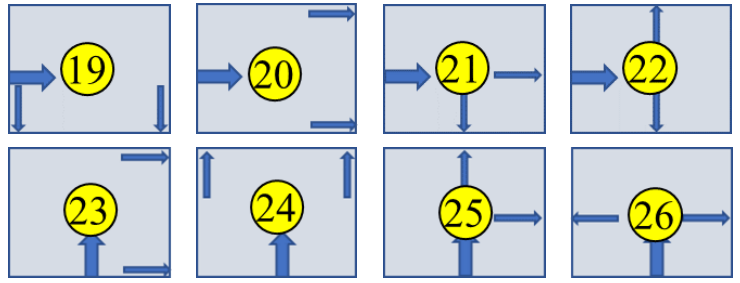
Figure 17. Schemes for the battery pack with a single inlet and double outlet.